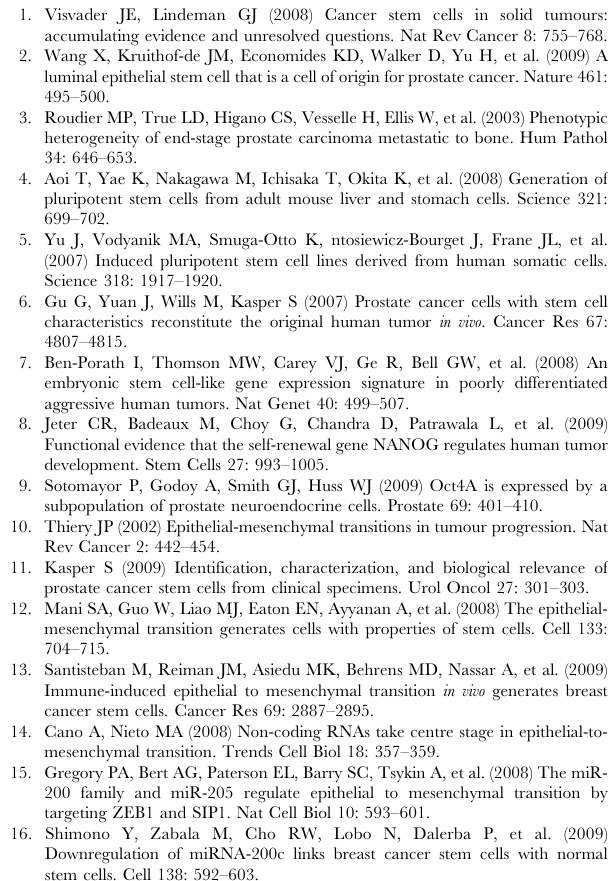
Table S2 Fold change in the expression of genes associated with stem-like cells in PDGF-D over-expressing PC3 cells compared to PC3 Neo cells.